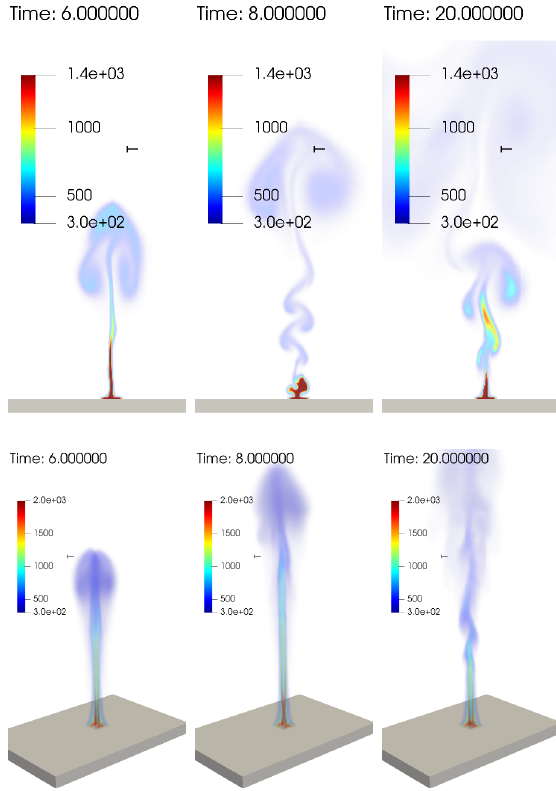
Fig. 3. Simple combustion simulation in 2D (31536 elements) and 3D (834616 elements), temperature field at various time in- stants. Constant fuel source fixed to 10 g · m − 2 · s − 1 .